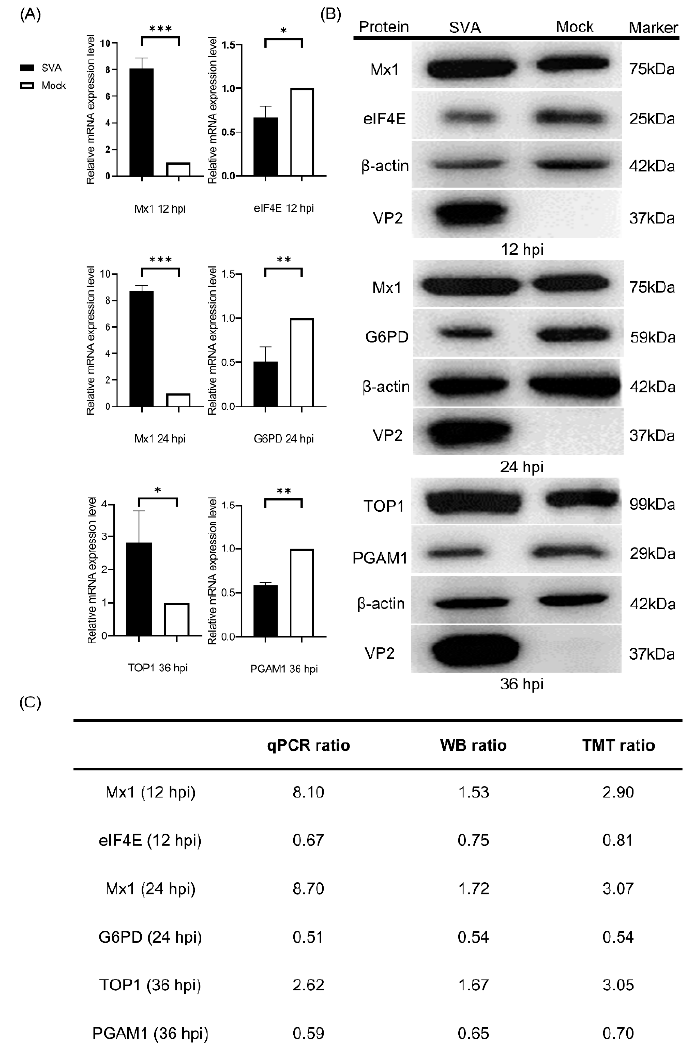
Figure 2. Validation of the differentially expressed proteins (DEPs) identified by tandem mass tags (TMT)-coupled LC-MS/MS analysis. ( A ) Quantitative real-time PCR (qPCR) analyses of the relative mRNA expression levels of Mx1, eukaryotic initiation factor 4E (eIF4E), glucose 6 phosphate dehydrogenase (G6PD), topoisomerase I (TOP1) and phosphoglycerate mutase 1 (PGAM1) in PK-15 cells in response to SVA infection. PK-15 cells were mock infected or infected with SVA SDta/2018 at an MOI of 5. At 12, 24 and 36 hpi, the cells were harvested and processed for qPCR analysis using β -actin gene as the internal control. Error bars indicate the standard error of three independent experiments (Student’s t test; * p < 0.05, ** p < 0.01 and *** p < 0.001). ( B ) Western blot (WB) analyses of the five representative DEPs in PK-15 cells in response to SVA infection. PK-15 cells were infected as in ( A ) and then subjected to WB analyses using rabbit anti-Mx1, -eIF4E, -G6PD, -TOP1 and -PGAM1 mAbs as the primary antibodies and with β -actin as the internal loading control. The SVA VP2- specific mAb 2F5 was used to track the progression of viral infection. The relative molecular weights of each target protein are indicated on their right side. ( C ) The relative mRNA ratio (qPCR ratio) and densitometric ratio (WB ratio) of the five representative DEPs between SVA- and mock-infected PK-15 cells was quantified and normalized to β -actin (WB ratio), which were compared with their respective ratios of the MS data (TMT ratio).